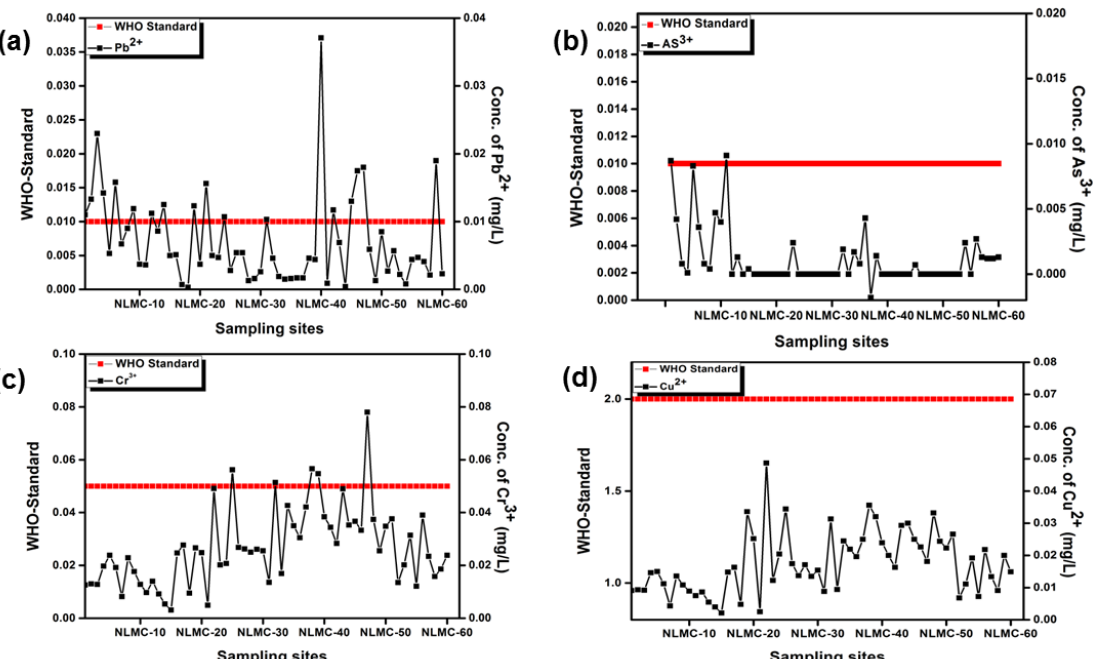
Figure 4. The plot between the concentration of heavy metals vs. the standard values by the WHO at different sampling sites of the district of Neelam, AJK. ( a ) Pb ( b ) As, ( c ) Cr 3+ , and ( d ) Cu 2+ against the WHO standards.